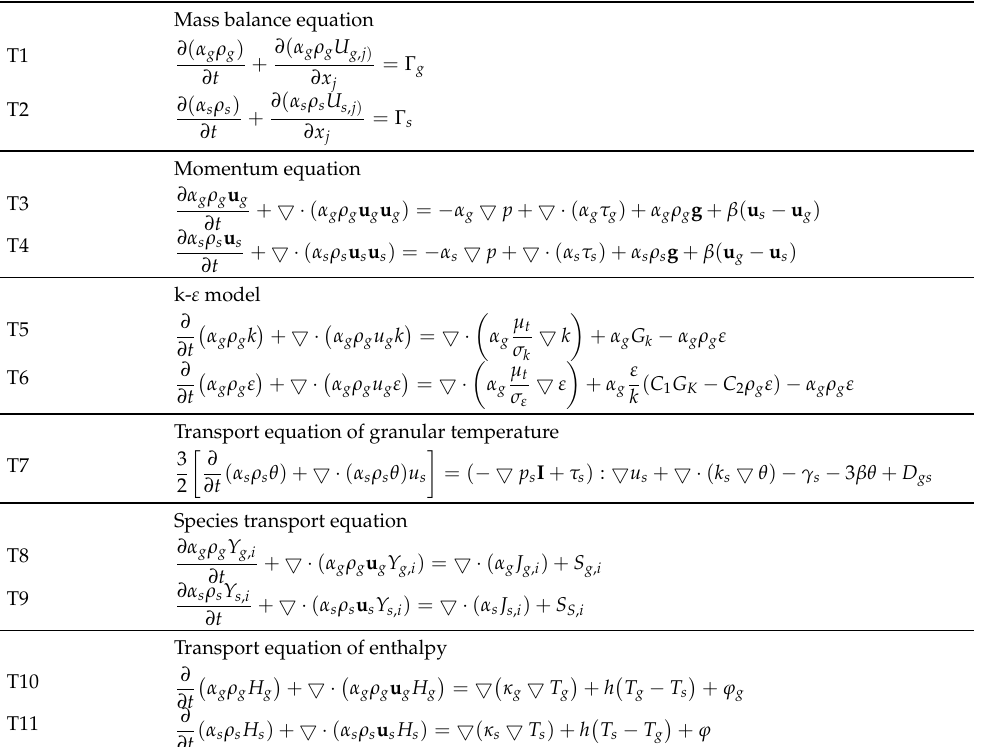
Table A1. Transport